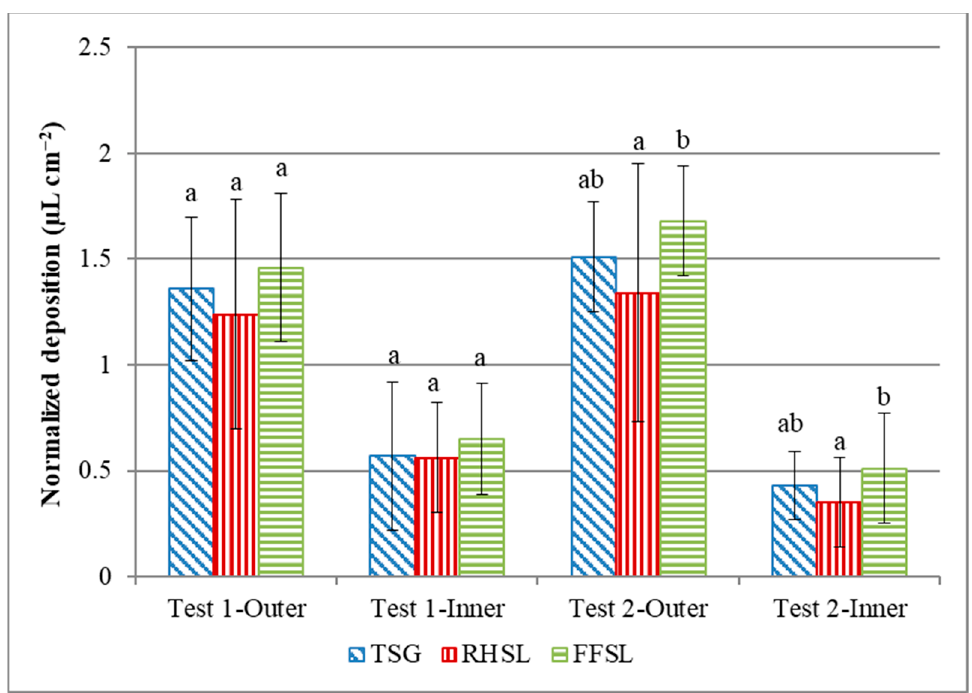
Figure 6. Normalised deposition ( µ L cm − 2 ) in the outer and inner zones of the canopy. The same letter means no significant differences (Duncan’s test, p < 0.05). Bars signify the means ± SD of the data. TSG: trigger spray gun, RHSL: rotating-handle spray lance, FFSL: flat-fan spray lance.